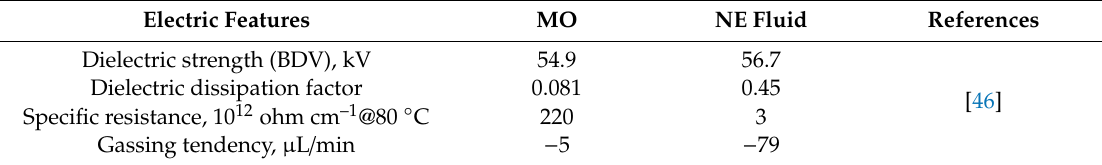
Table 3. Electrical features of natural ester fluid and mineral oil